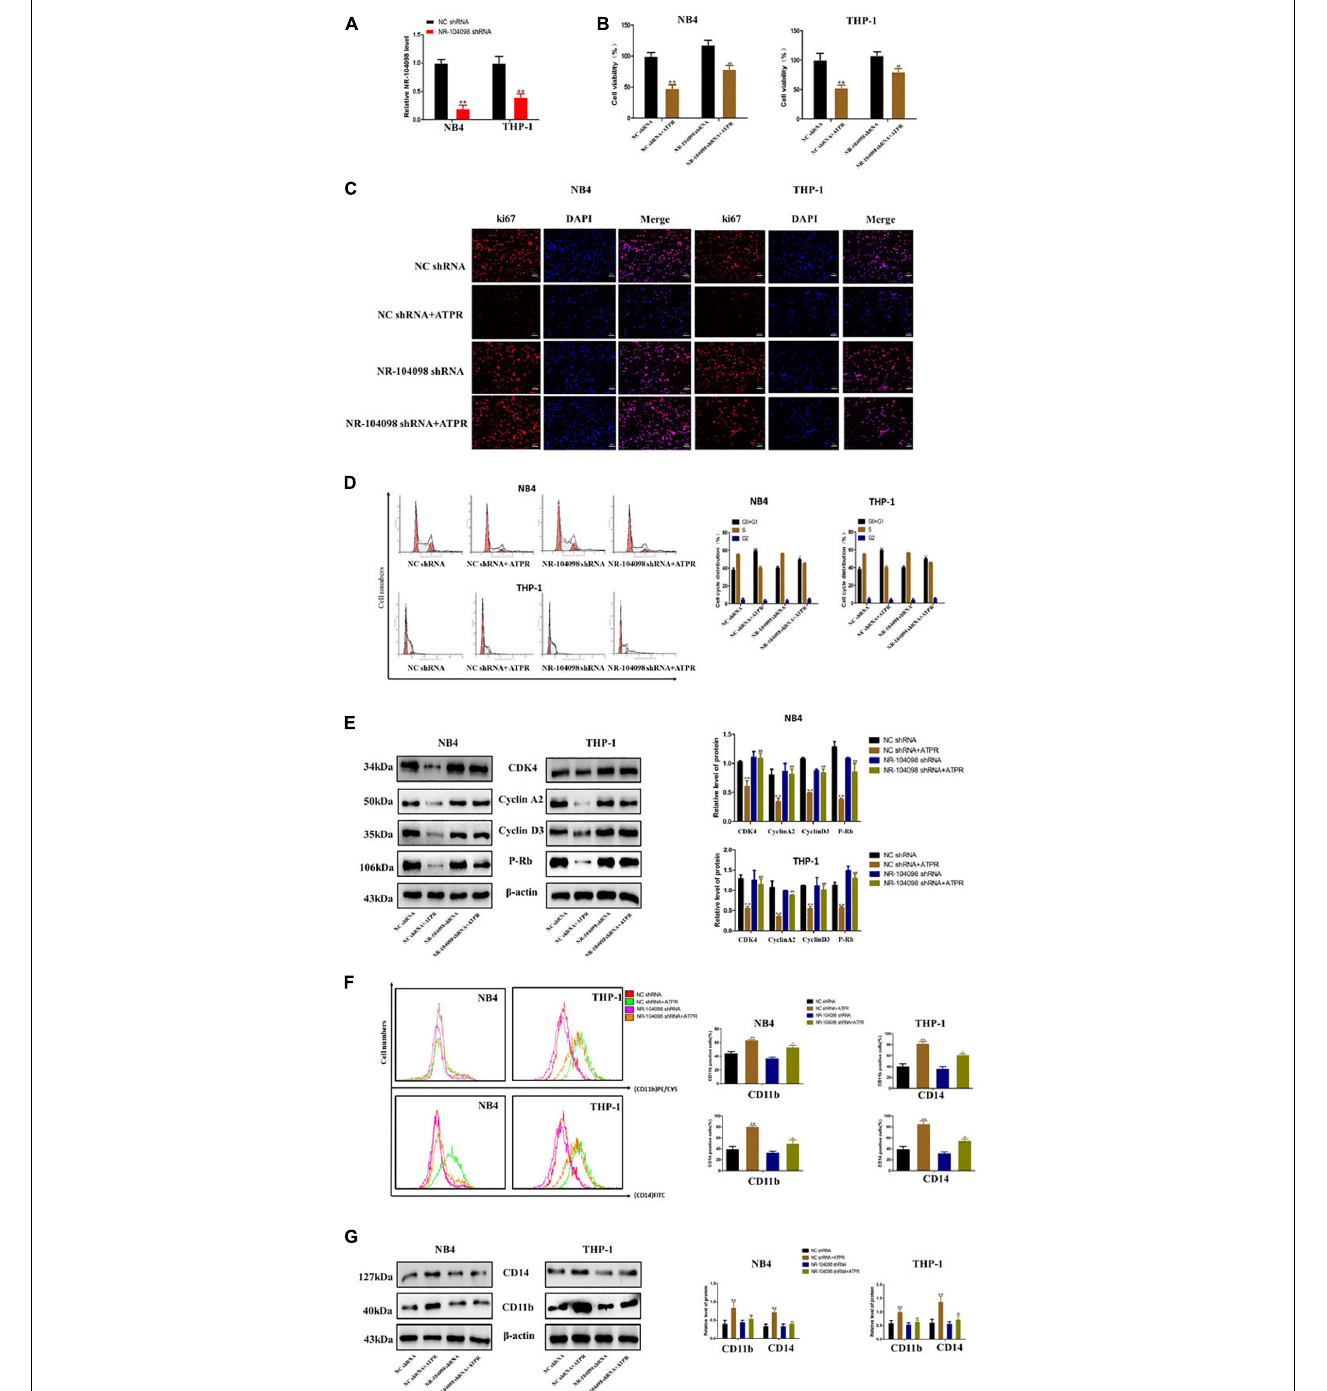
FIGURE 6 | Knockdown of lncRNA NR-104098 inhibited ATPR-suppressed proliferation and induced differentiation of AML cells in vitro . (A) The expression levels of lncRNA NR-104098 in NB4 and THP-1 cells were detected by RT-qPCR assay, with transfection of lncRNA NR-104098 shRNA or the NC shRNA for 48 h. (B) AML cells were treated with ATPR or Solvent. 72 h later, cells were collected and cell viabilities were evaluated by CCK8 assay. (C) Meanwhile, ki67 protein expression detected by immunofluorescence. (D) Cell cycle were analyzed by flow cytometry analyzed. (E) Western blot analysis of cyclin D3, cyclin A2, P-rb, and CDK4 protein levels in AML cells after treated. (F) Cell differentiation were analyzed by flow cytometry. (G) Western blot analysis of CD11b and CD14 protein levels in AML cells after treated. β -Actin served as a loading control. Data are presented as the mean ± SD of three independent experiments. ∗ p < 0.05, ∗∗ p < 0.01, compared with the NC shRNA group. # p < 0.05, ## p < 0.01, compared with the ATPR group.